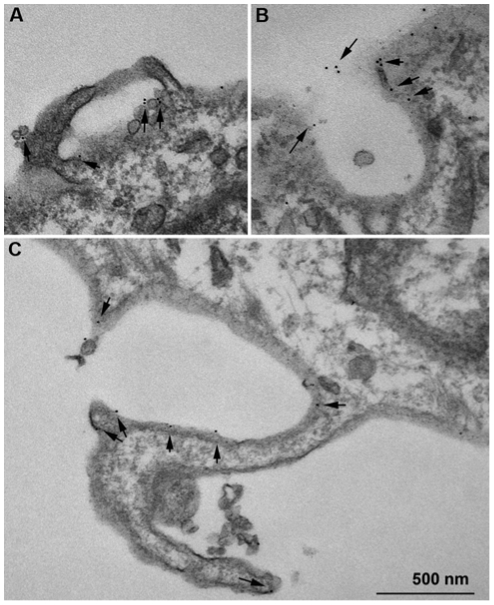
Majority of Duffy antigen is present on the surface of endothelial cells within vesicles and plasma membrane extensions.Duffy antigen was detected on membrane surfaces by pre-embedding TEM in DIH cells as described in Materials and Methods. All panels are imaged from different cells. Duffy antigen (5 nm gold, arrows) was seen located associated with plasma membrane extensions and invaginations. These structures are large (>100 nm) and have no consistent morphology, suggesting they are macropinosomes.